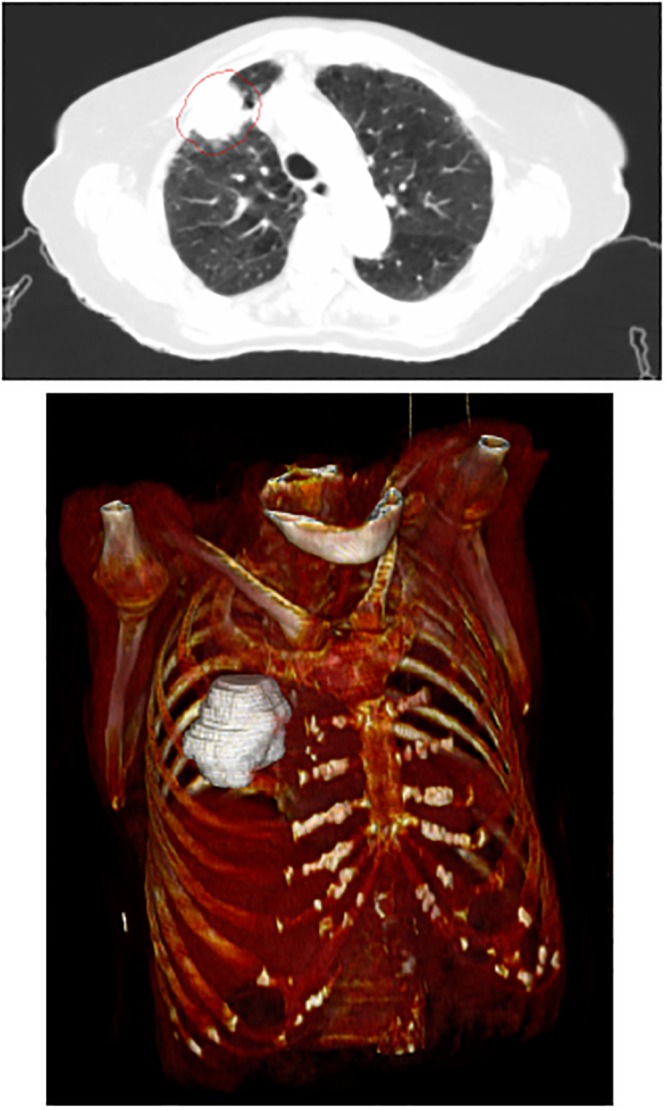
Example of ROI (Region of Interest) in 2D and 3D images for a patient in the adaptive group (lung window).